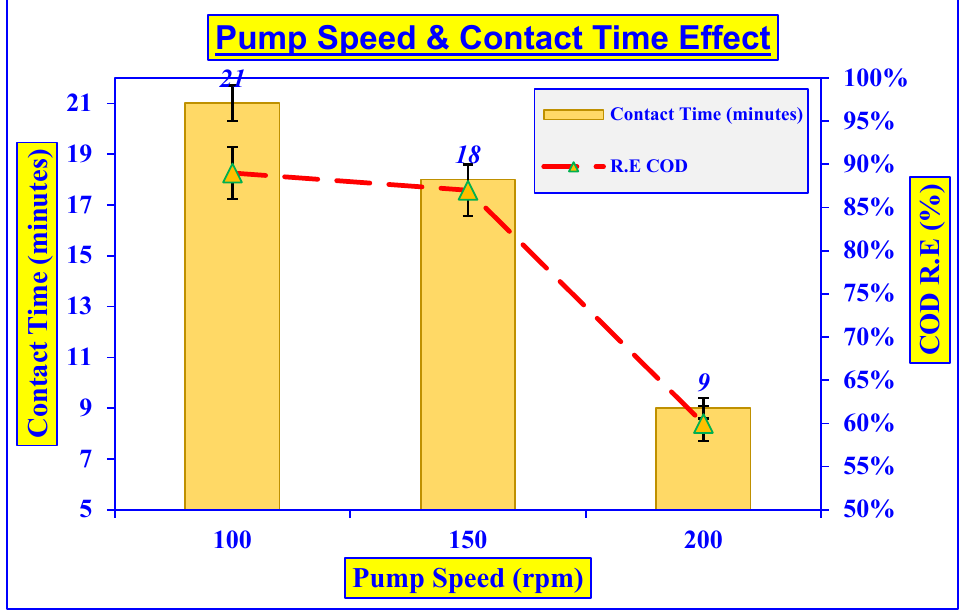
Figure 3. Pump speed and Contact time optimization in ozonation process (peristaltic pump speed = 100 rpm, 150 rpm and 200 rpm; t = 9 min, 18 min and 21 min; Initial COD = 490 mg/L; O 3 = 82.5 ± 2.5 mg/L; pH = 6.9 ± 0.2; volume = 4 L; T = 25 ± 2 C).